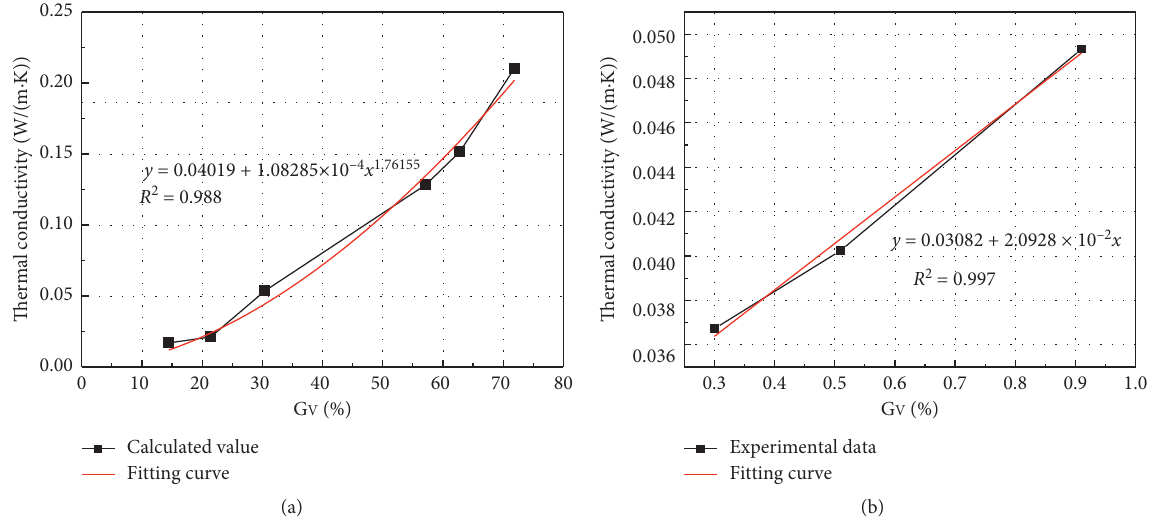
Figure 15: Fitting analysis of the thermal conductivity of different thermal insulation materials. (a) Phenolic insulation board. (b) Peeled polyurethane insulation.